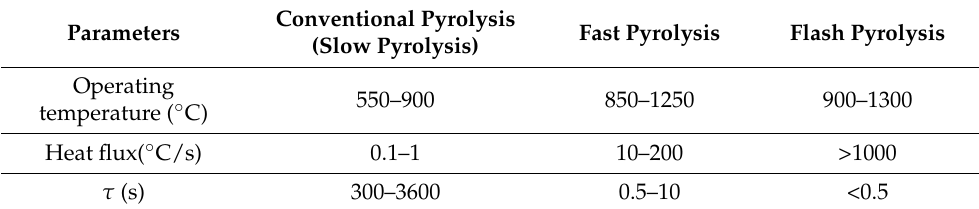
Table 2. Main operating conditions for MSW pyrolysis process.